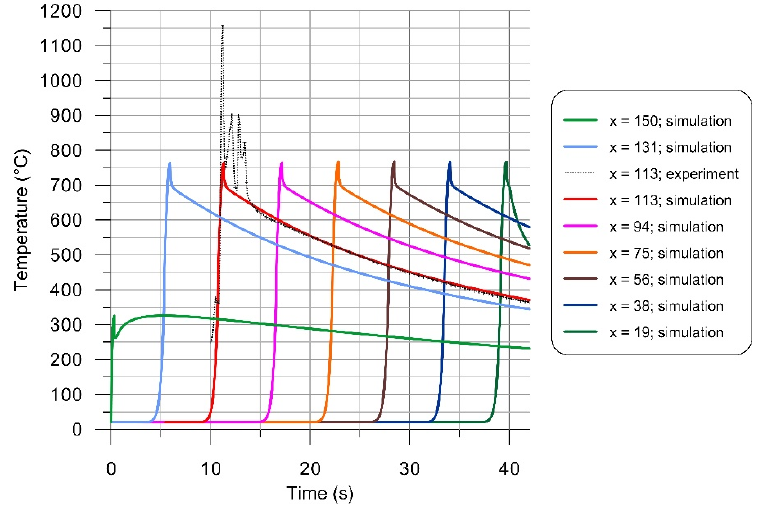
Figure 7. Time-runs of temperature at selected locations x on laser-irradiated surface (y = 0, z = 0).